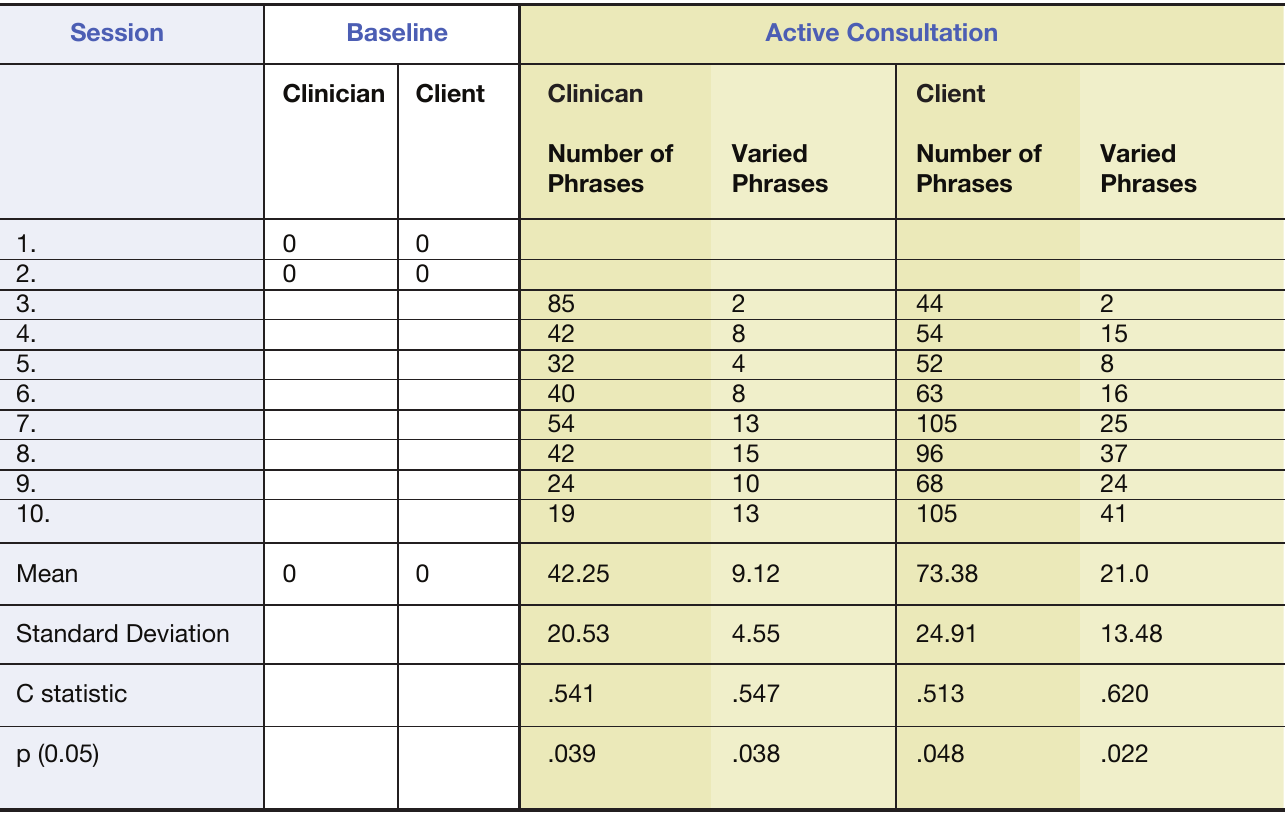
Data is derived from the averaging the Number of Phrases and the Number of Varied Phrases produced by the clinician and the client for each session of the Baseline and Active Consultation Phases of the